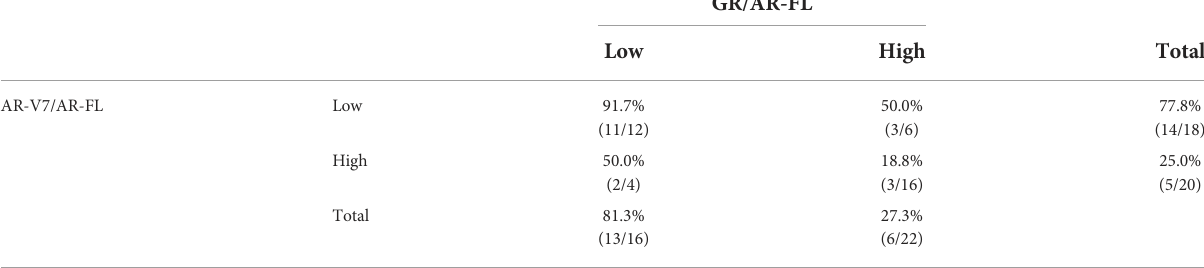
TABLE 2 PSA response rates in patients with CRPC treated with AR-targeting agents in relation to AR-V7/AR-FL and GR/AR-FL ratios.